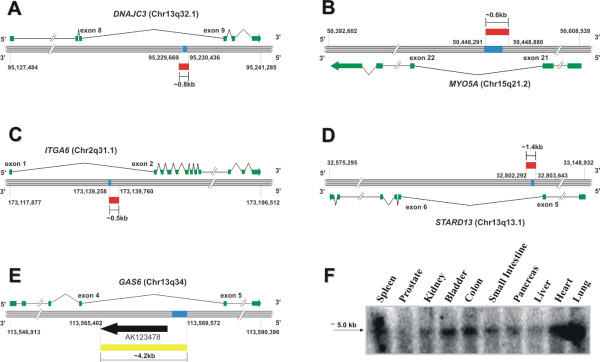
Characterization of androgen-responsive non-coding intronic RNAs. Selected intronic transcripts extended by RACE-PCR (A-D, red boxes) or gene-specific PCR (E, yellow box) are shown. Extended unspliced antisense intronic transcript fragments were mapped to the genomic sequence (A-E, gray lines) relative to the respective spliced protein-coding transcript expressed in the opposite strand (A-E, green arrows). Double-stranded cDNA clones spotted on the microarrays are represented as blue boxes (A-E). A previously described antisense unspliced intronic transcript mapping to GAS6 locus is shown (E, black arrow). Chromosome coordinates and the length of extended intronic transcript fragments are indicated. (F) Strand-specific multi-tissue northern blot using probes complementary to the antisense intronic transcript mapped in the GAS6 locus.